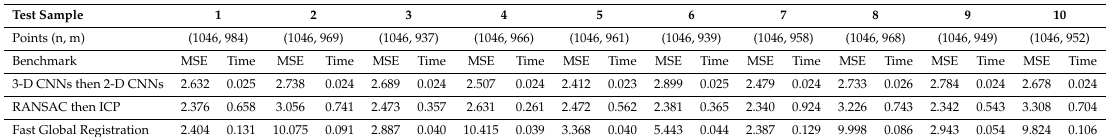
Table 9. The comparisons about MSE and computation time of “Armadillo” data for test samples from 1 to 10.